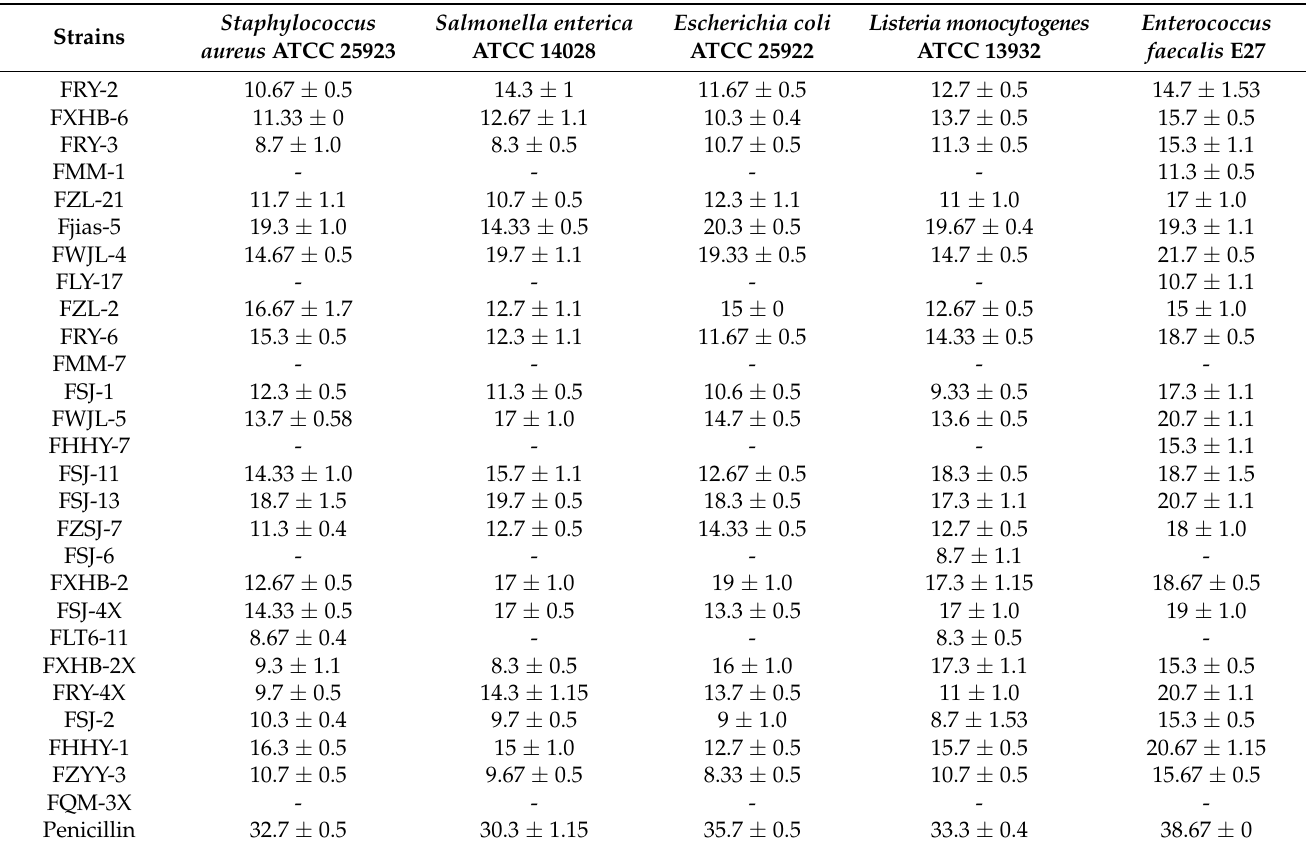
Table 2. a Results of the antimicrobial activity of selected